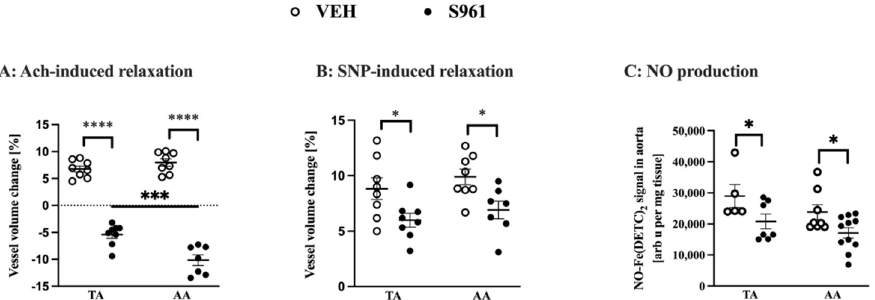
Figure 1. Effects of S961 treatment on vascular function of the thoracic and abdominal aorta. ( A ): Assessment of endothelium-dependent vascular response to acetylcholine (Ach) 30 min after administration in the thoracic aorta (TA, VEH n = 8, S961 n = 7) and abdominal aorta (AA, VEH n = 8,